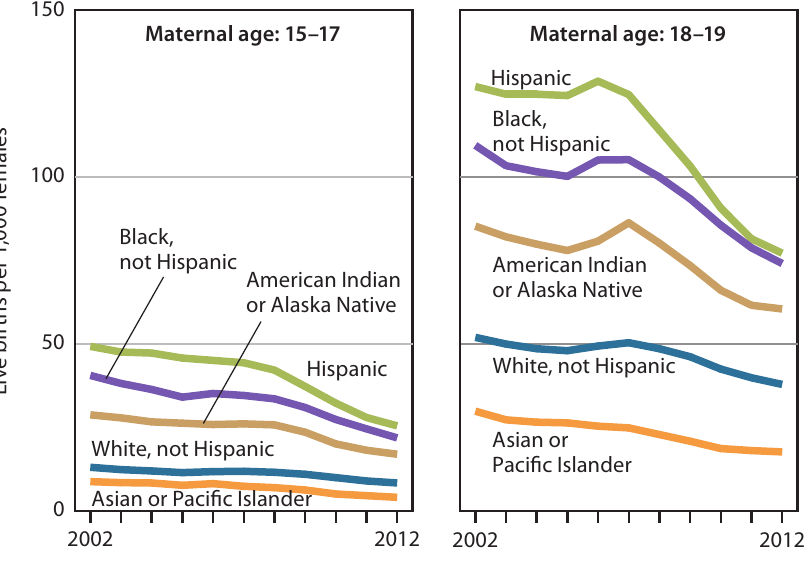
(Table 4). Between 2002 and 2012, birth rates